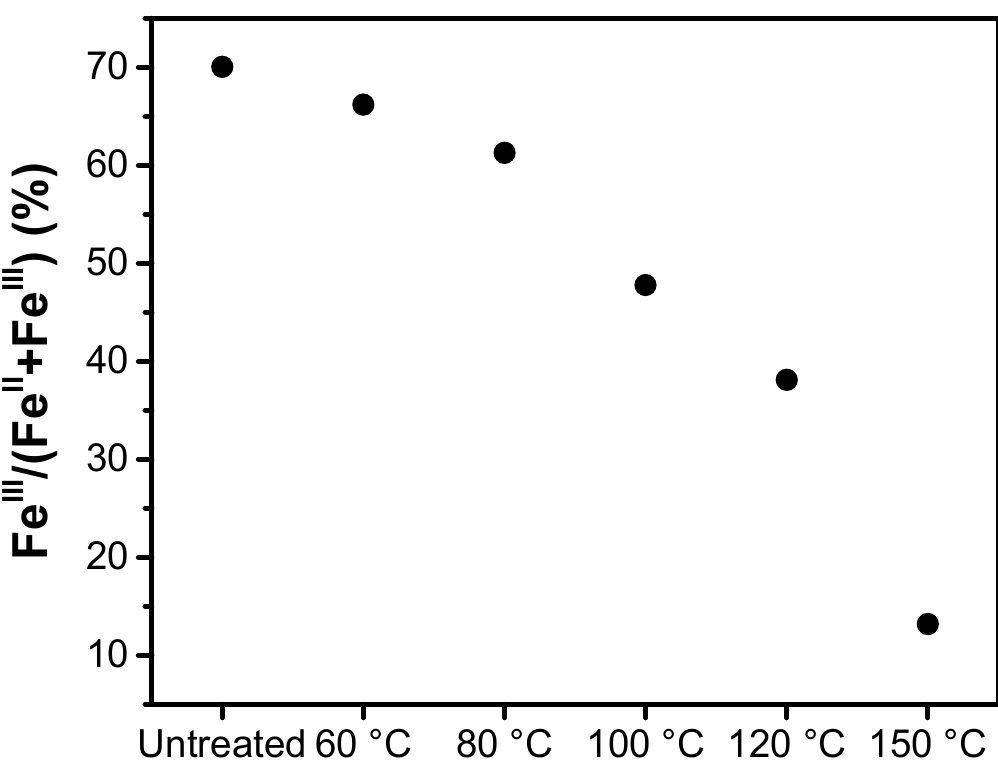
Figure 7. Fraction of Fe III with respect to the total iron content of the lattice as a function of the temperature employed during the treatment of the CuHCF powder.